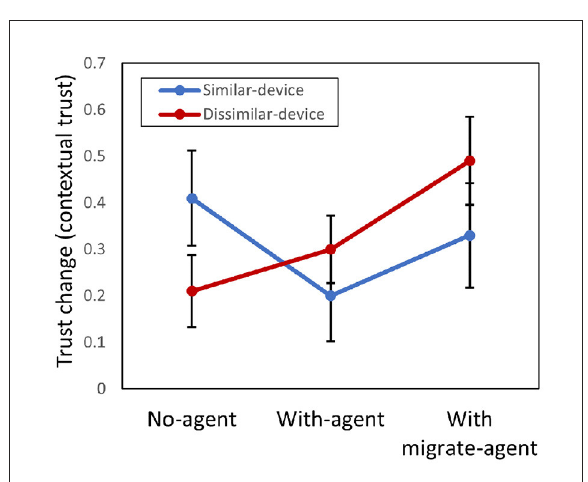
FIGURE6 Results of comparison between mean scores of trust change of contextual trust. Error bars represent standard